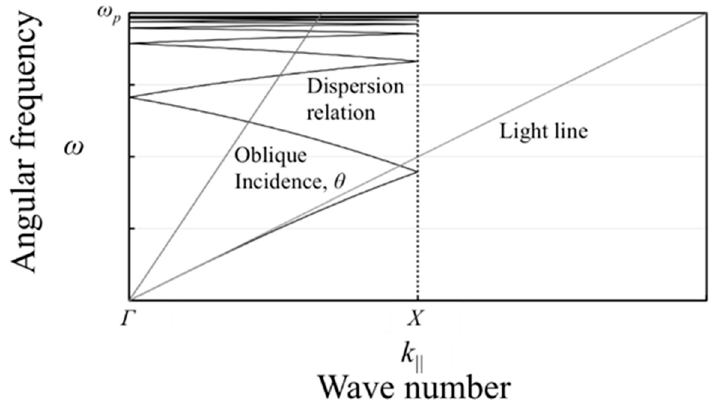
Figure 4. The real dispersion relation of SSPP with lattice scattering effects.